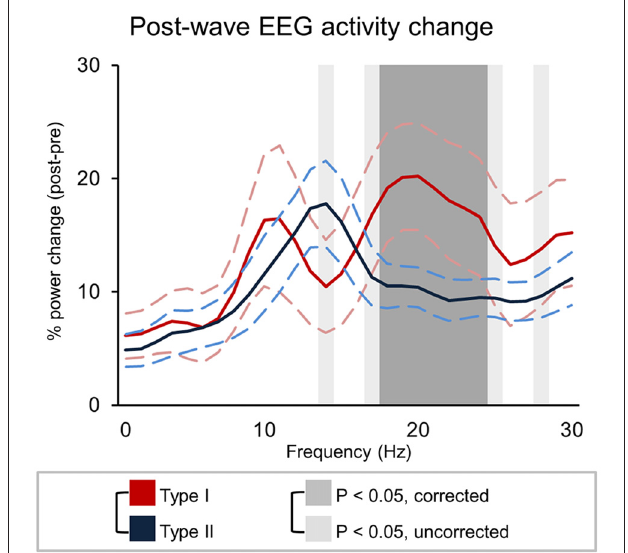
FIGURE 7 | Signal power changes following type I and type II slow waves. The graph show the percent power variation between pre- and post- slow wave periods ( ± SE, dashed lines). Dark-gray shadows indicate Bonferroni corrected p < 0.05, while light gray indicate results at uncorrected p < 0.05.